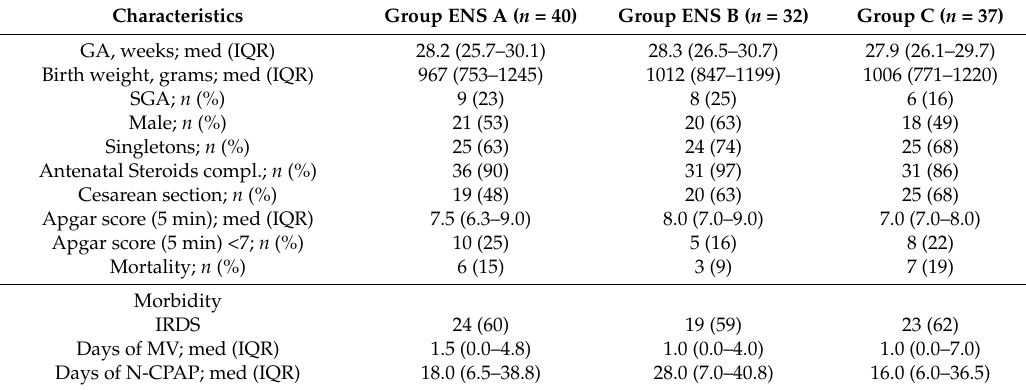
Table A2. Cohort characteristics of all patients included in the Early Supplementation